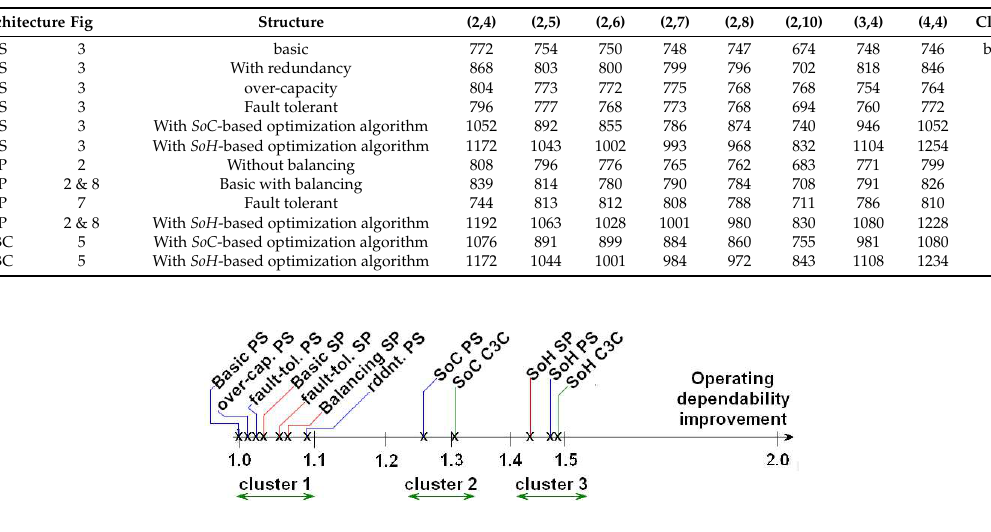
Figure 12. (3,4) structure O dep improvement. Table 3. Simulation results: operative dependability.